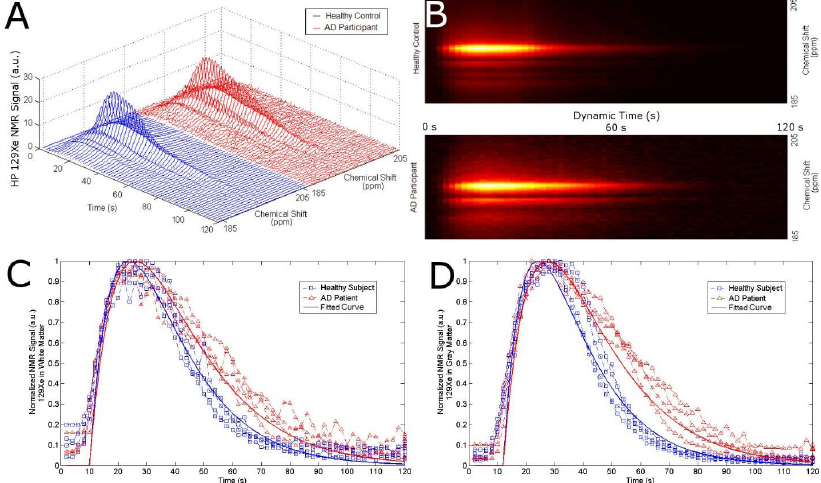
Figure 2. ( A ) Stack plot of dynamic 129 Xe NMR spectra for healthy controls (blue) and AD patients (red). ( B ) Topographic “streak” plot of ( A ) depicting the NMR dynamic spectra from the top with SNR in “hotter” colors. Notice a higher SNR in AD patients for a longer time than that of the healthy controls. SNR of 129 Xe-WM ( C ) and 129 Xe-GM ( D ) as a function of time for healthy controls (blue) and AD participants (red). The participants inhaled 500 mL of HP 129 Xe and held their breath for 20 s. 129 Xe MRS from the brain region was acquired every 2 s. Notice an increase in 129 Xe signal after approximately 10 s as the 129 Xe reached the brain. At 20 s, the participant exhaled and the 129 Xe signal began to decrease at different rates for AD participants vs. healthy controls for WM and GM.